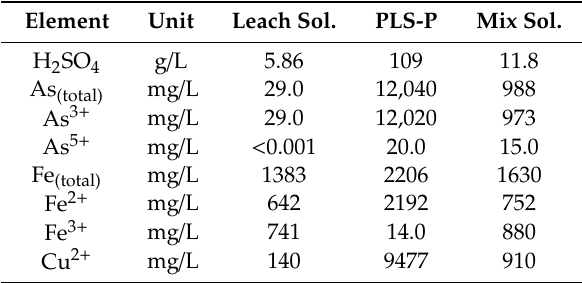
Table 5. Chemical analysis of the solutions used in the leaching tests.